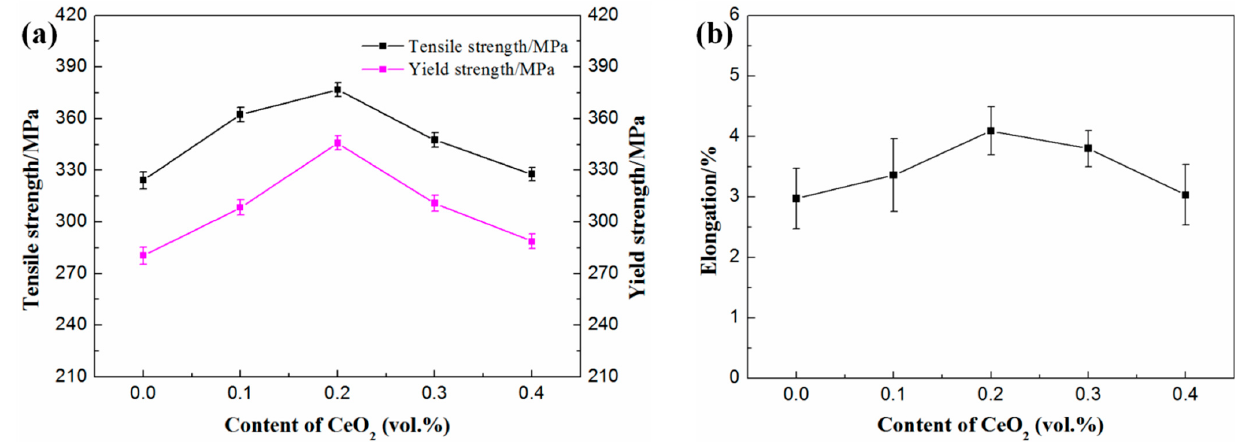
Figure 7. Tensile properties of SiCp/Al-Si composites with different CeO 2 contents: ( a ) tensile strength and yield strength; ( b ) elongation.